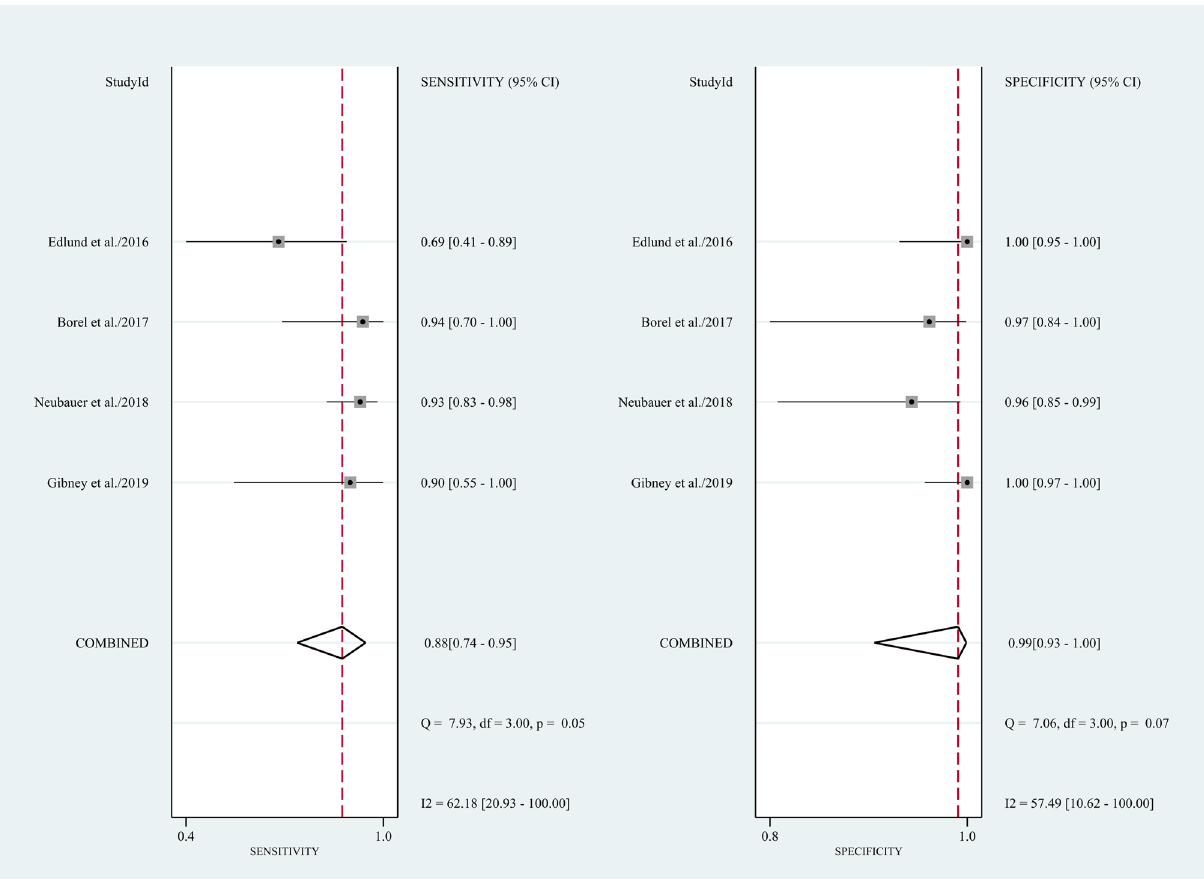
Figure 3. Forest plots of sensitivity and specificity for CBCT in scaphoid fracture diagnosis. Point estimates of sensitivity and specificity from each study are shown as solid circles. Error bars represented as 95%